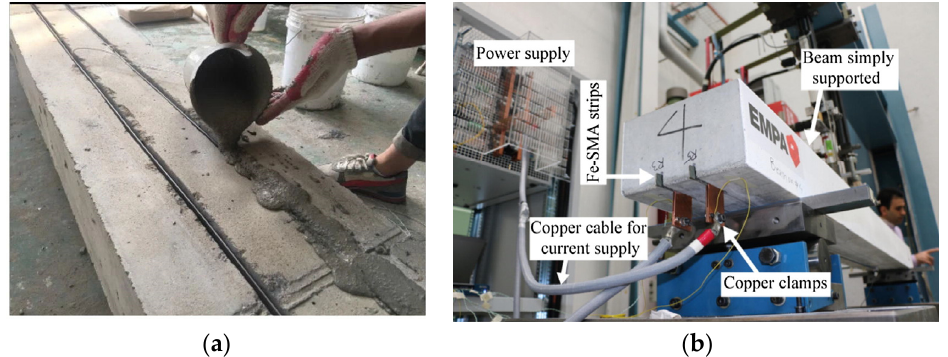
Figure 21. The NSM-strengthened technology [79,97]: ( a ) filling with cement mortar, ( b ) activation by the resistive heating.